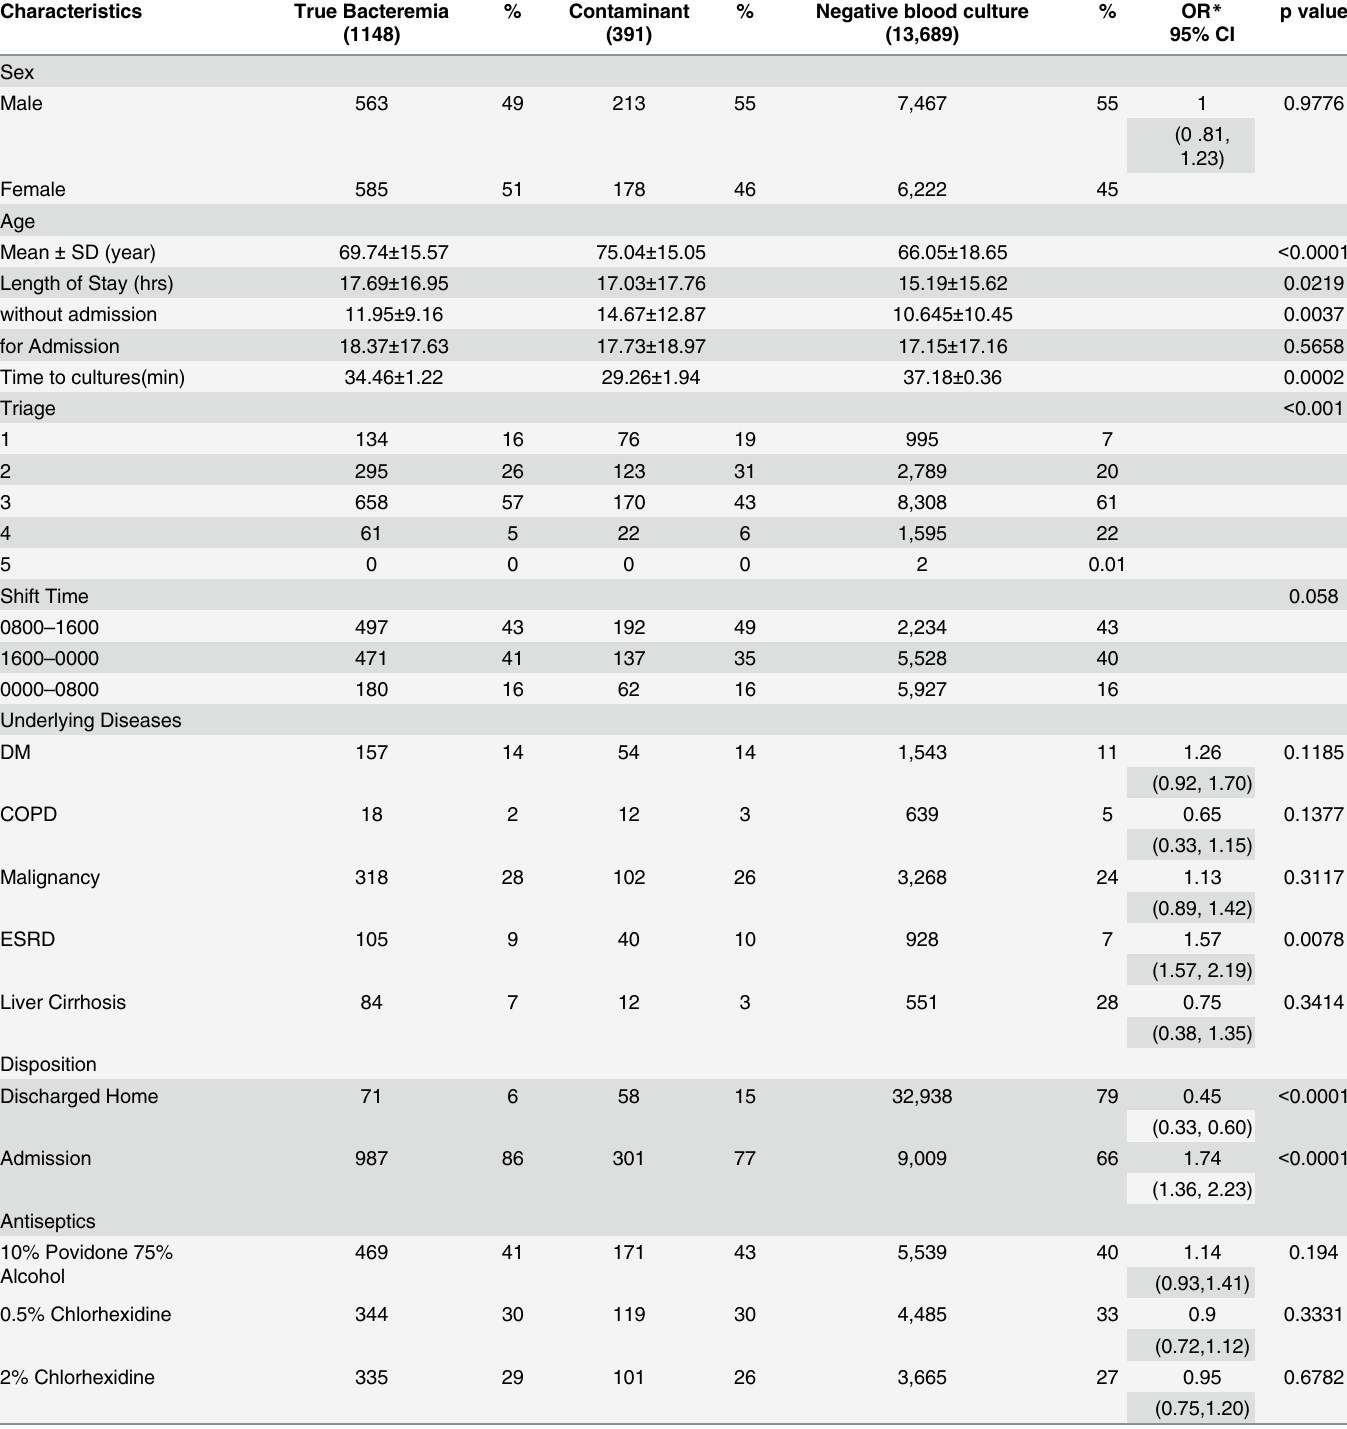
Table 1. Factors associated with blood culture contamination during August 2011 to December 2012 in the